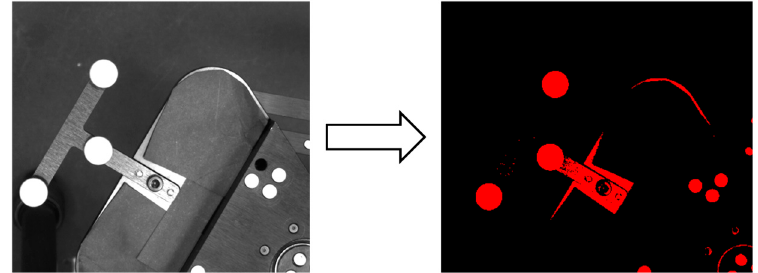
Figure 12. Image threshold in LabVIEW. ( left ) Grayscale image; ( right ) binary image.